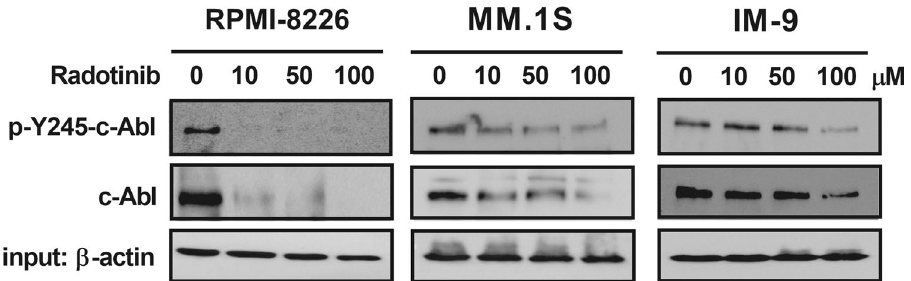
Figure 1. Radotinib reduces activation and expression of the c-Abl in MM cells, including RPMI-8226, MM.1S, IM-9. Cells were incubated with 0, 10, 50, and 100 μM radotinib for 72 h. The c-Abl activation and expression by radotinib were confirmed by immunoprecipitation